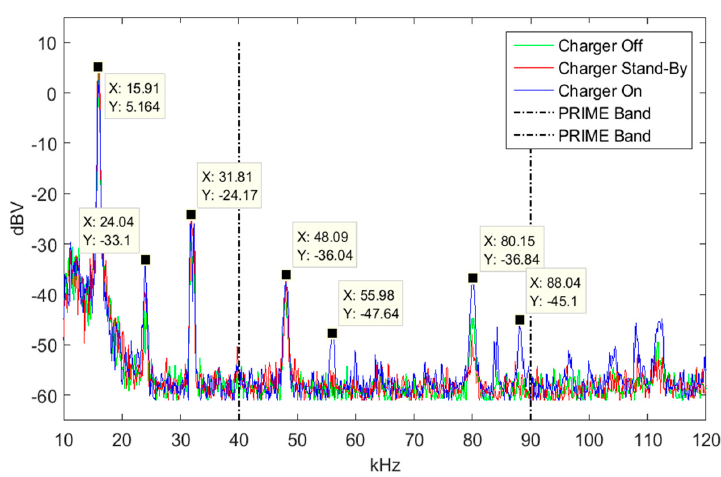
Figure 22. Spectrum recorded at PV1 SM for different states of the battery charger with the rest of inverters switched on.